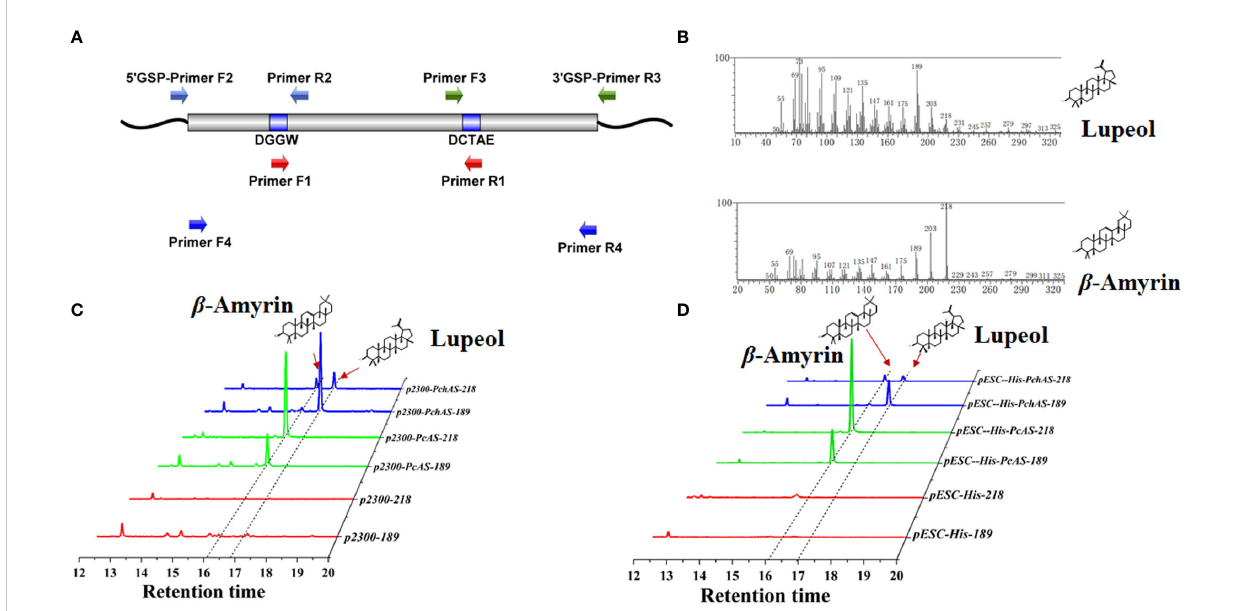
FIGURE 2 Functional characterization of AS homolog genes from Pulsatilla ceruna and P. chinensis . (A) A simplifed overview of gene cloning of AS from P. ceruna and P. chinensis ; (B) Mass spectra of b -amyrin and lupeol detected by GC – MS; (C) GC – MS analysis of extracts from transient transformation Nicotiana benthamiana leaves which expressed AS genes from P. cernua ( PcAS ) and P. chinensis ( PchAS ). pCAMBIA2300 empty vector and pSAK277- NbHAMGR co-transformation N. benthamiana leaves were used as control; (D) GC – MS analysis of extracts from engineered yeast which expressed PcAS and PchAS . ERG7-de fi cient yeast that transformed with pESC-His empty vector was used as control; The 218 and 189 ion counts of b -amyrin and lupeol were shown,